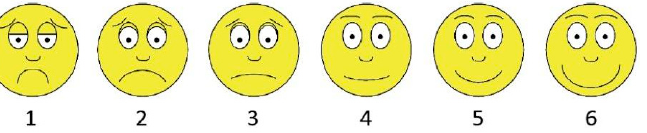
Figure 1. Scale used to capture momentary happiness before and after volunteering at Cradles to Crayons (C2C) Giving Factory (Study Crayons (C2C) Giving Factory (Study 2).